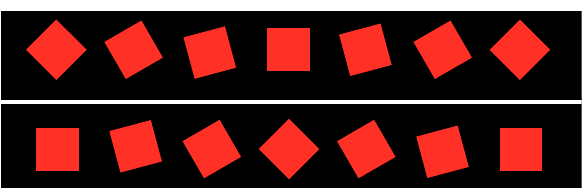
Figure 10: motion